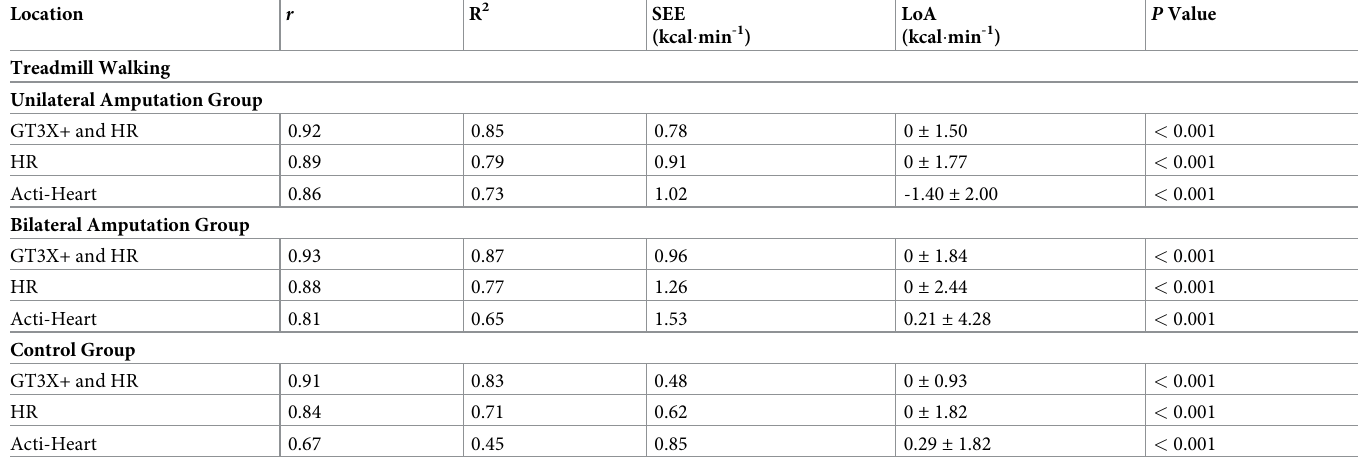
in treadmill intensity (Table 2). The mean PCI across all velocities for each group ranged from 0.67 to 1.01, 1.03 to 1.45 and 0.38 to 0.61 in the unilateral, bilateral and control group, respectively.